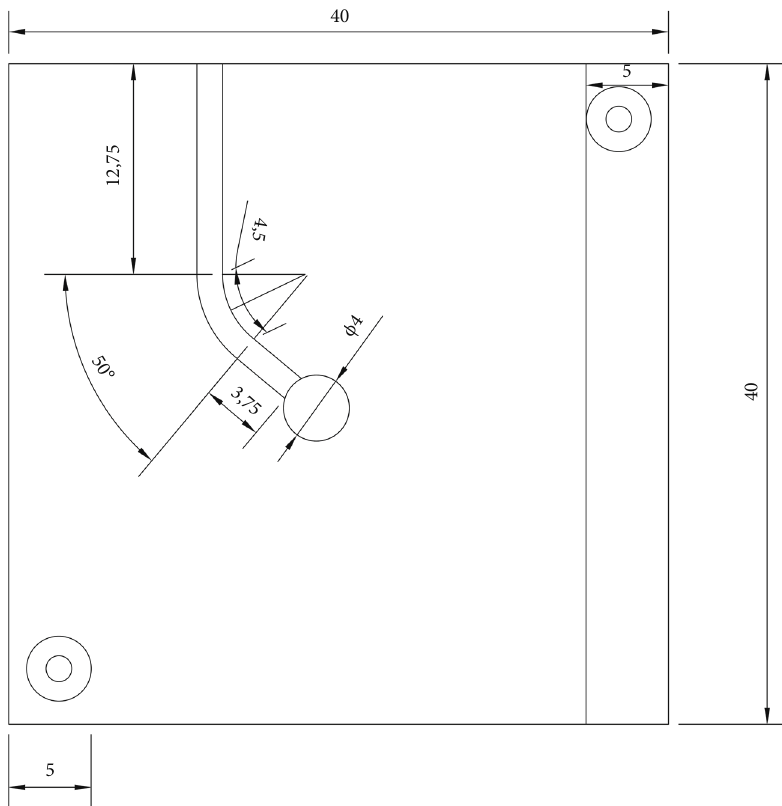
Figure 1: Dimensions of the arti fi cial canal performed by (AutoCAD).